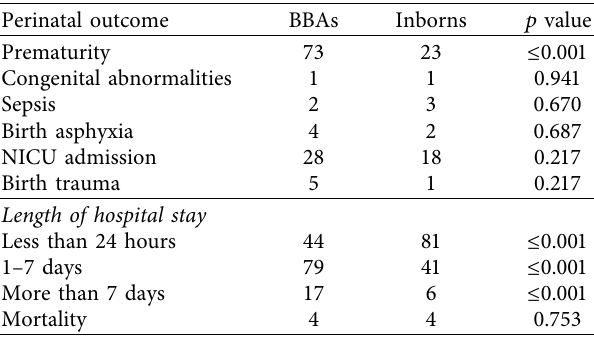
Table 3: Perinatal outcomes.